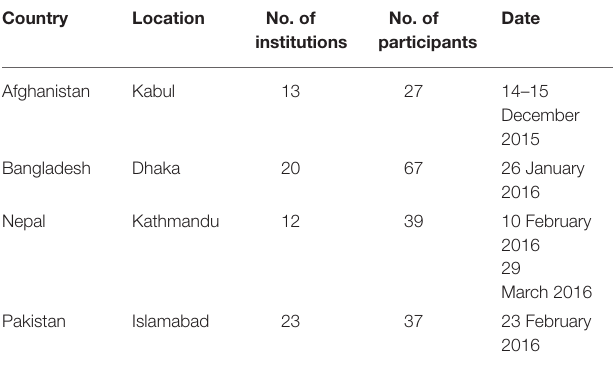
TABLE 1 | Country consultation workshops in four countries in 2015–2016. Country